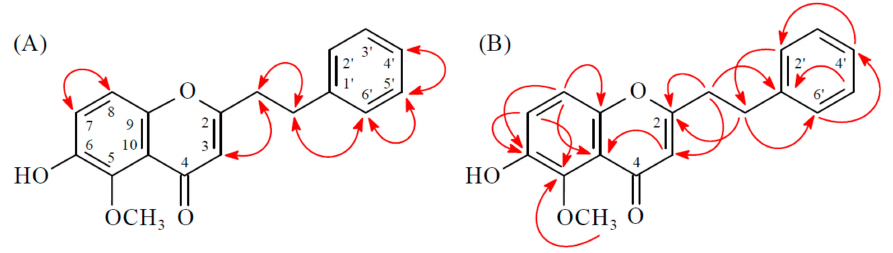
Figure 5. Key NOESY ( A ) and HMBC ( B ) correlations of 4